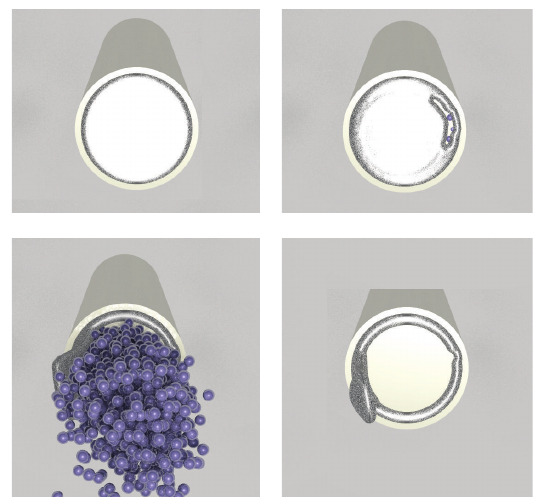
Figure 12: 0.25mm seal bottom